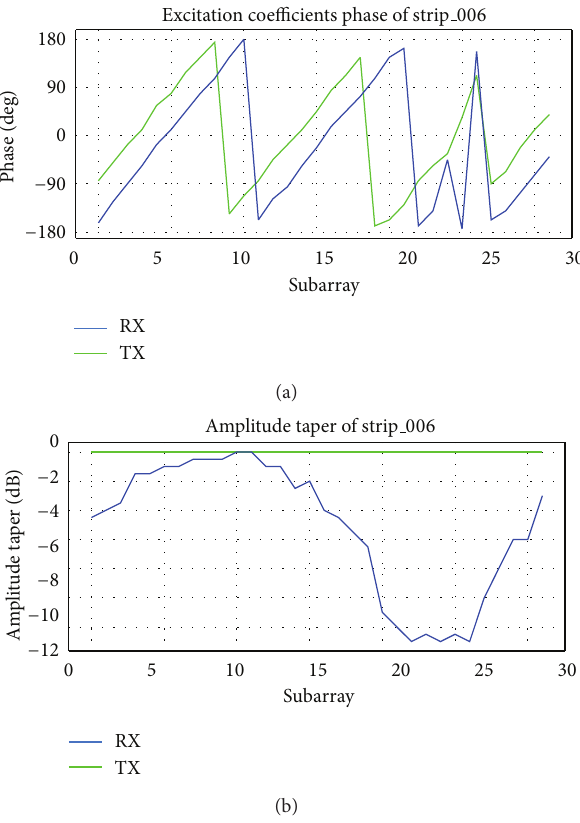
Figure 2: Excitation coefficients of a tapered